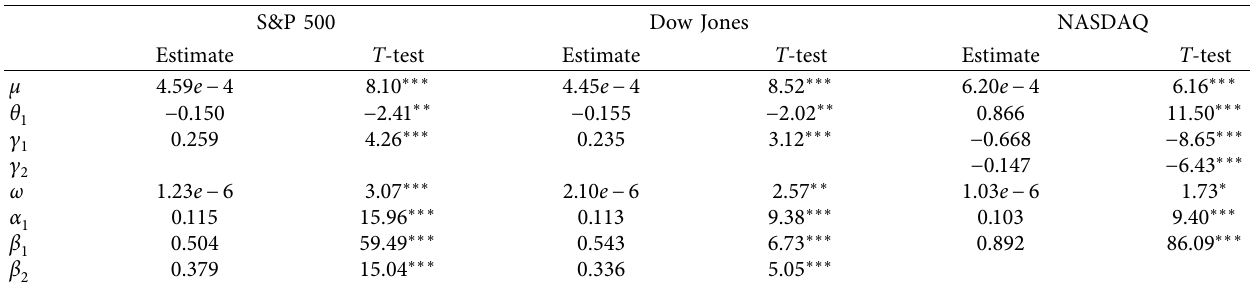
Table 3: ARMA-GARCH estimation results.